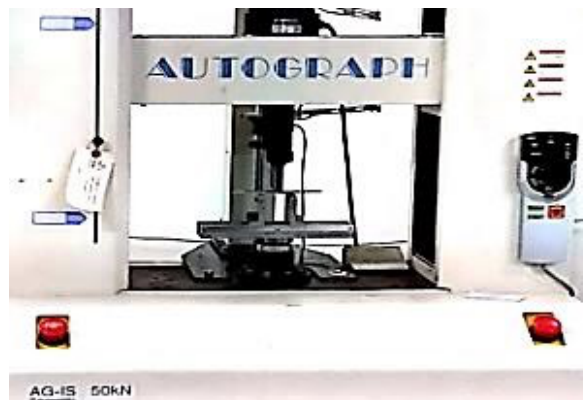
Fig. 5. Flexural test carried out for glass/jute hybrid composite specimen in AUTOGRAPH